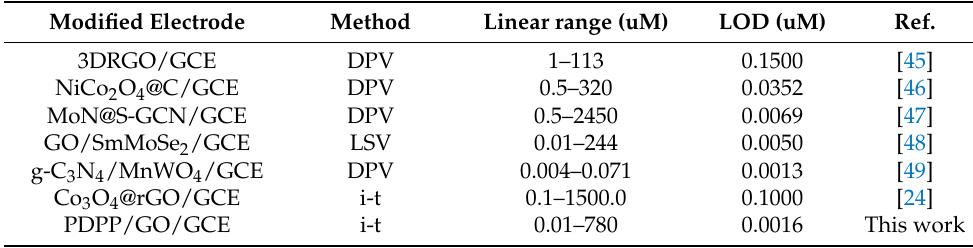
Figure 9. Current–time curve of the PDPP/GO/GCE at − 0.62 V for successive additions of different concentrations of CAP in stirred PBS (pH 6.5) ( a ) and an enlarged view ( b ); ( c ) The calibration curve of the low concentration range (0.01–1 uM) and ( d ) high concentration range (1–780 uM) obtained from the amperometric response. Table 1. Evaluation of CAP based on various modified